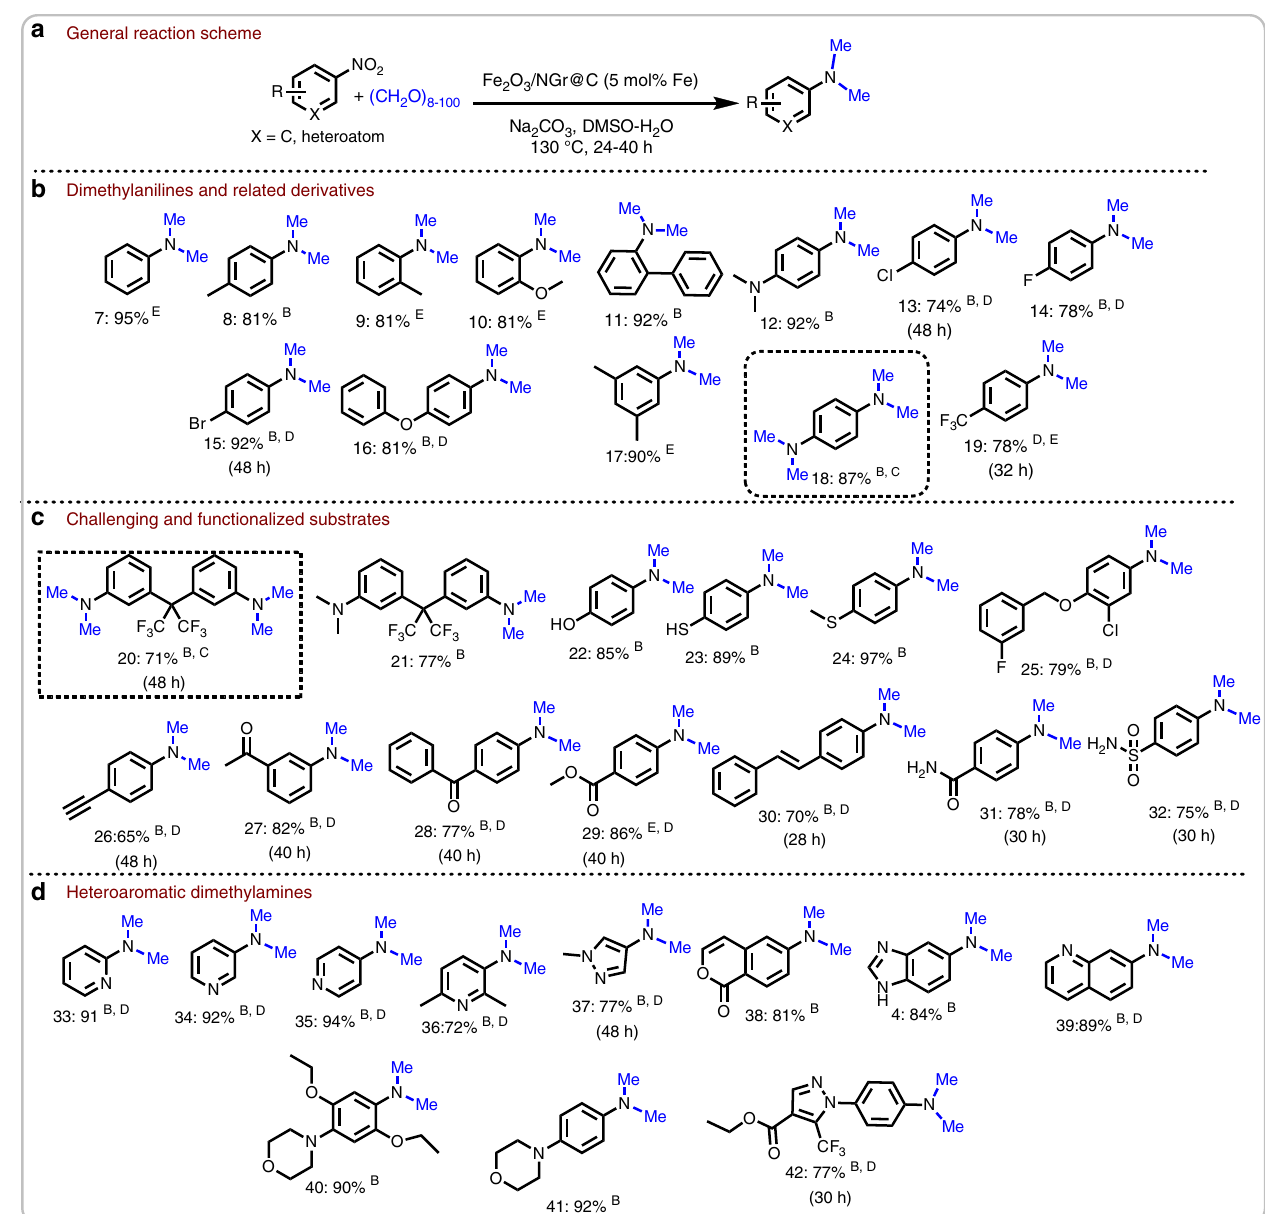
Fig. 3 Synthesis of (hetero)aromatic N,N- dimethylamines A . a General scheme representing reductive amino-methylation. b Synthesis of dimethylanilines and related derivatives. c Synthesis challenging and functionalized dimethylamines. d Synthesis of heteroaromatic dimethylamines A Reaction conditions: 0.5 mmol nitroarene, 50 mg Fe 2 O 3 /NGr@C, (5 mol% Fe), 10 mmol of paraformaldehyde (300 mg), 1 mmol Na 2 CO 3 , 2 mL DMSO-water (1:1), 130 °C, 24 h.